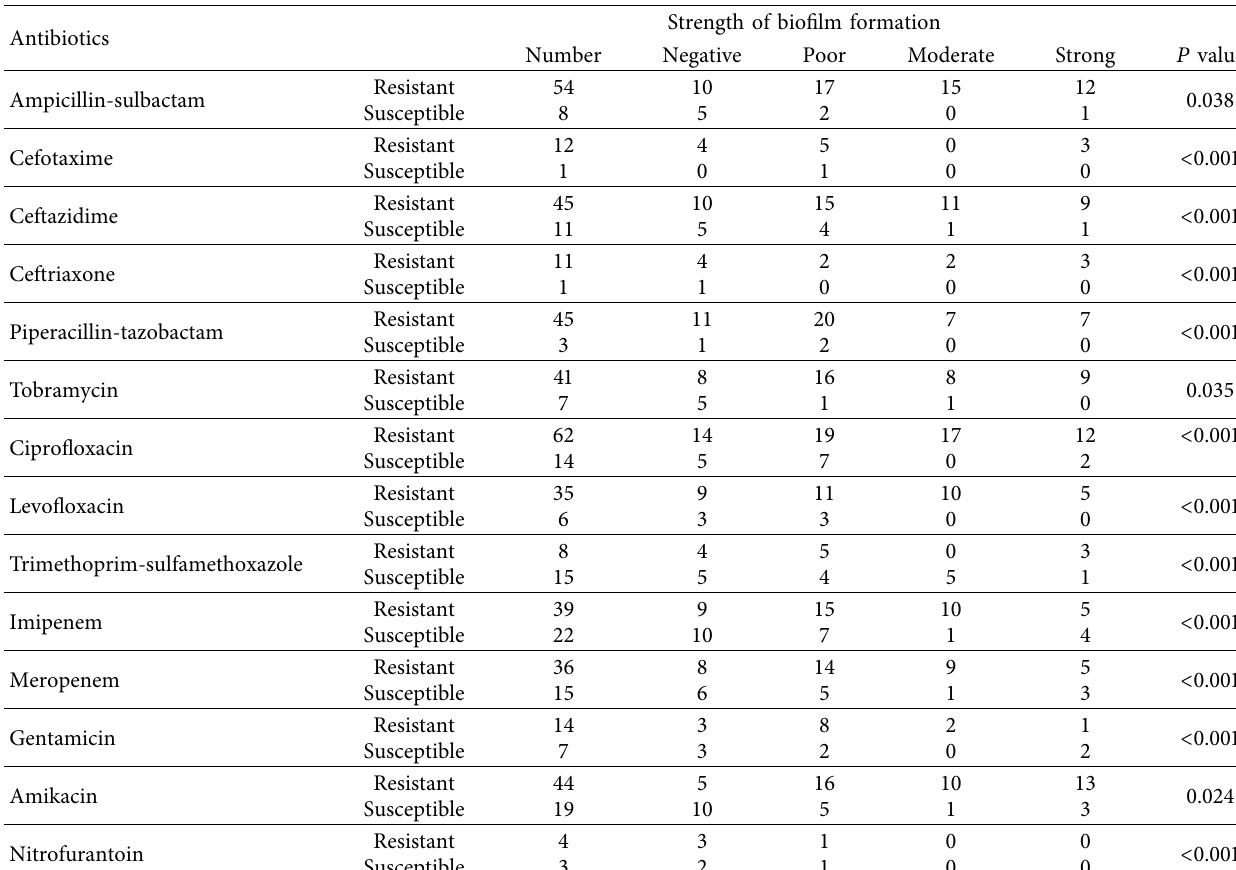
Table 3: Comparison of biofilm formation in antibiotic-resistant K. pneumoniae strains.